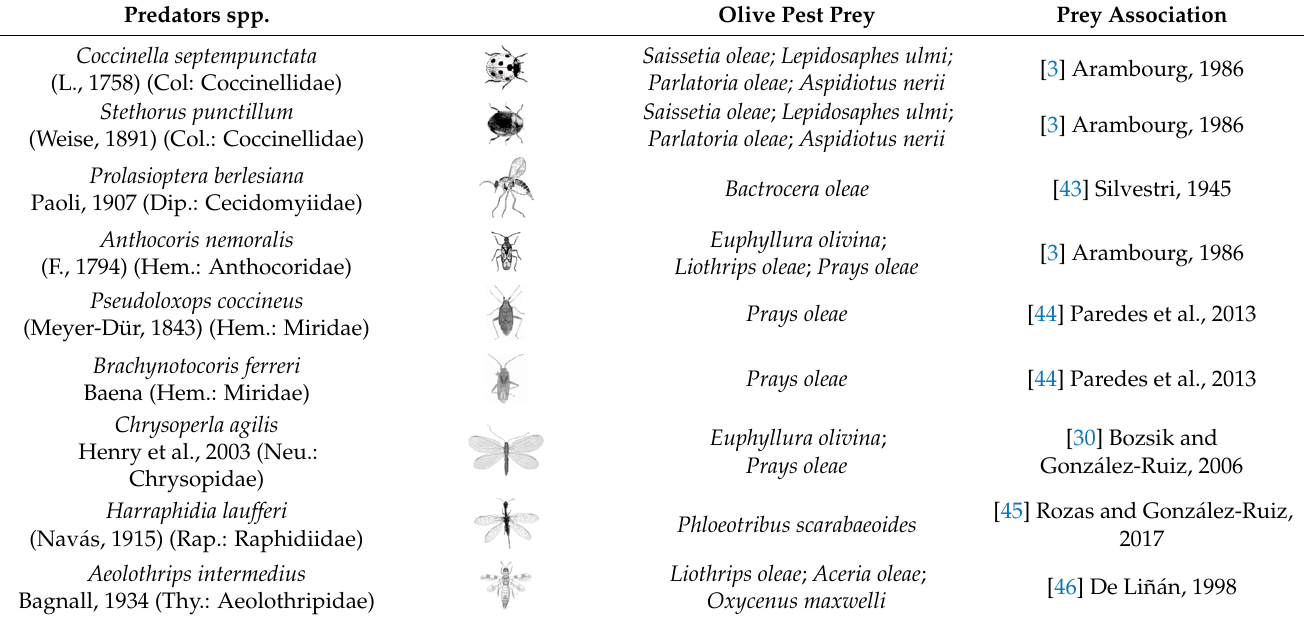
Table 3. Predator species captured in the sticky yellow traps, pest species they are associated with, and first bibliographical reference. Predators spp.